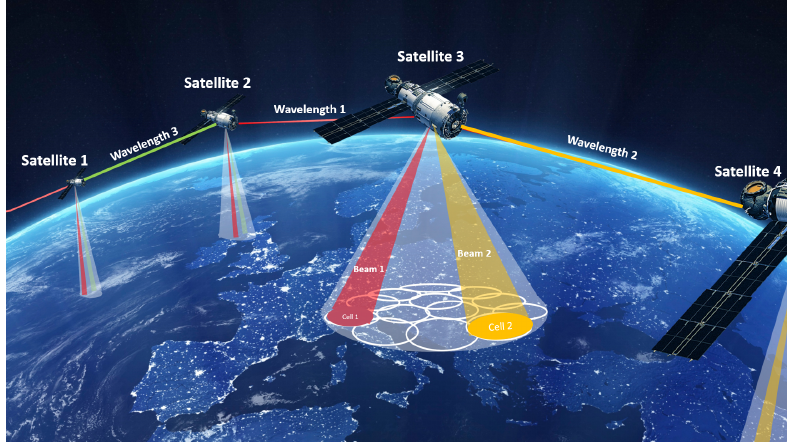
Figure 1. Low-orbiting satellite network employs inter-satellite laser communication and optically controlled millimeter wave-phased array. Wavelength multiplexing between constellations is used to transfer data from users in different cells. The wavelength multiplexing can be directly converted into the corresponding millimeter wave-beam pointing by unique characteristics of the array waveguide grating router structure.